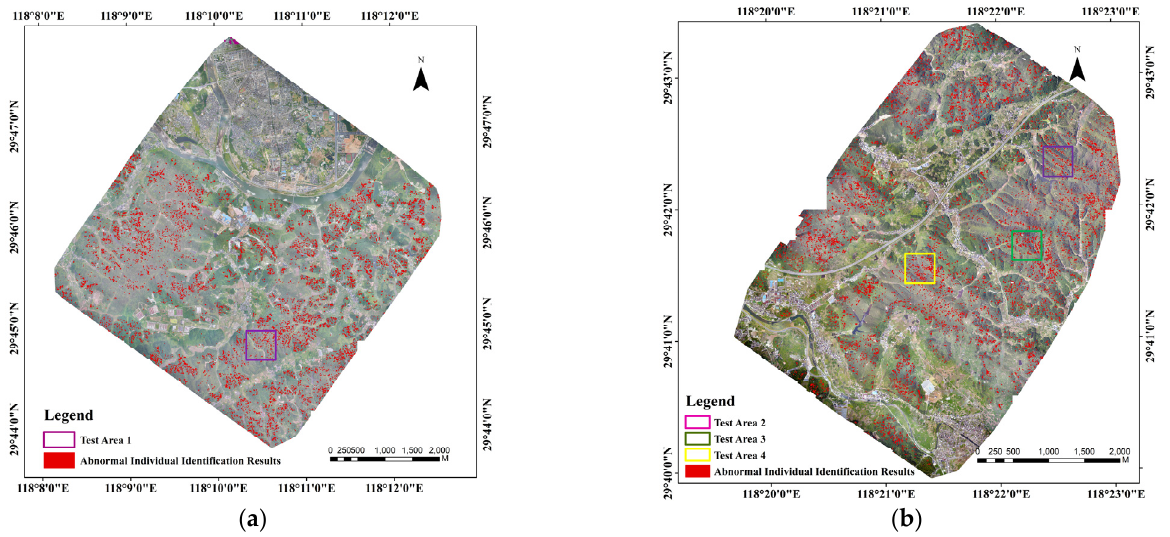
Figure 10. Results map of southern Anhui study area. ( a ) Huangshan study area A. ( b ) Huangshan study area B.